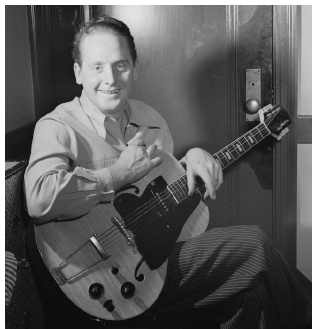
Figure 11. Les Paul, inventor of the solid-body electric guitar in 1943. His technology transformed popular music in ways they could not have foreseen. Public domain